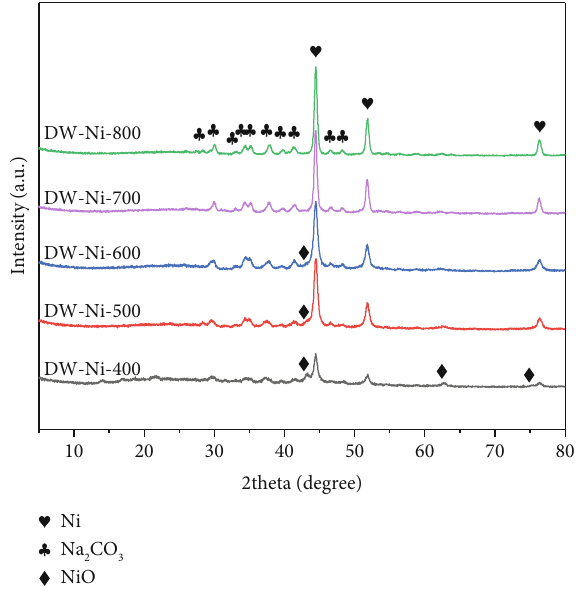
Figure 3: XRD of the catalysts prepared at di ff erent calcination temperatures.